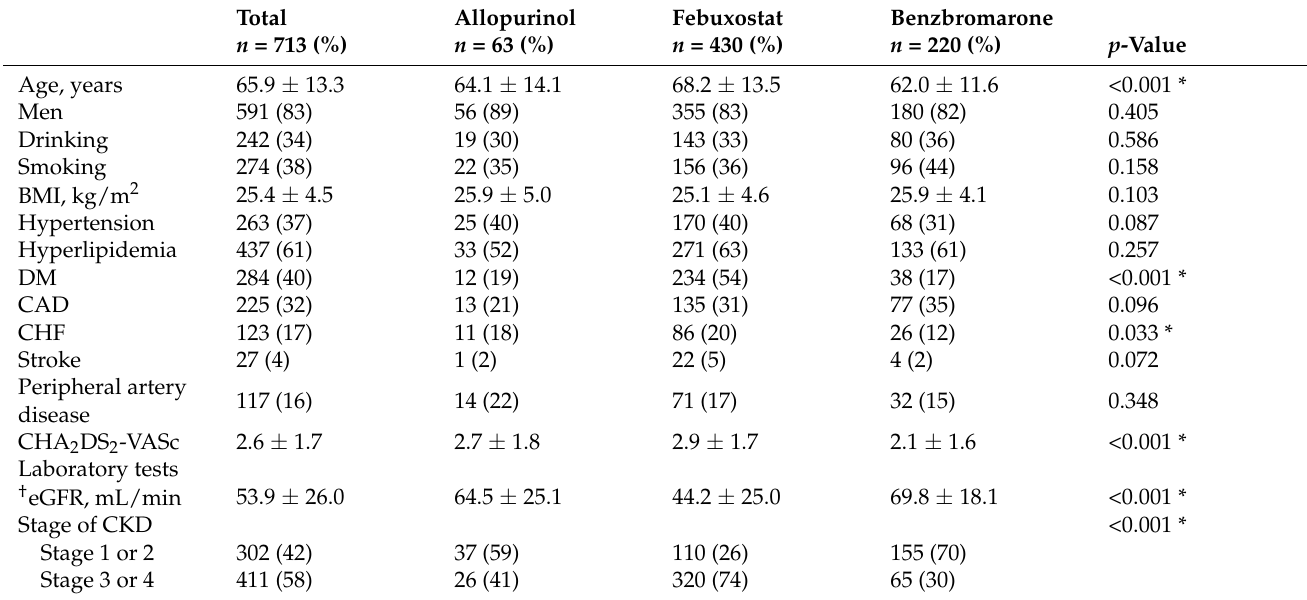
Table 1. Baseline characteristics of patients with gout receiving urate-lowering